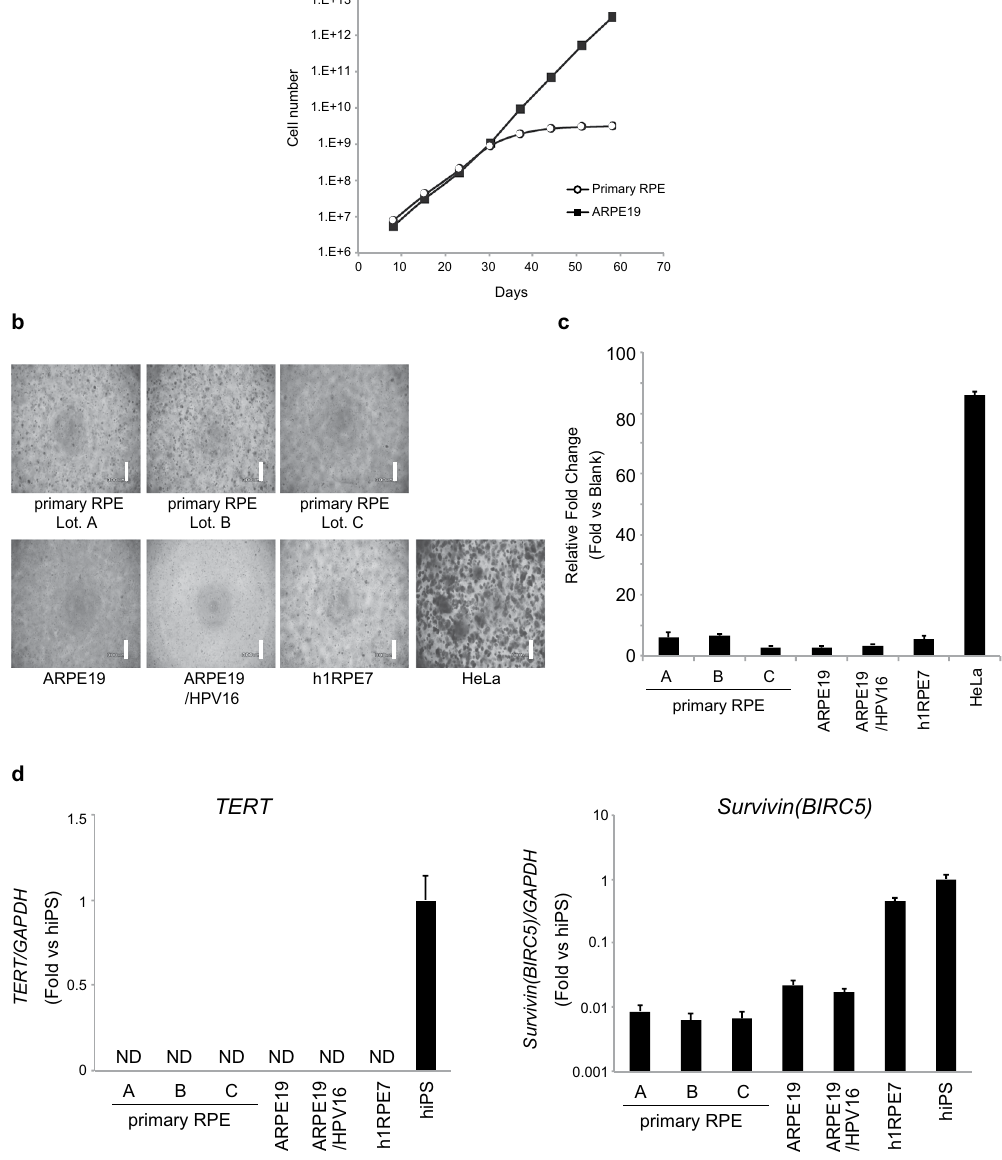
Figure 1. Immortalized RPE cells are undetectable by conventional in vitro assays. ( a ) Cell growth analysis of primary RPE cells and ARPE-19 cells. ( b , c ) A soft agar colony formation assay was carried out to detect immortalized RPE cells. Phase-contrast images of primary RPE cells, immortalized RPE cells, and HeLa cells cultured in soft agar medium for 30 days (b; Scale bars, 300 µ m). Quantification of the cellular DNA is shown in a bar graph. Results were expressed as a relative fold change of the value of blank well. Data are presented as the mean ± standard deviation of three independent experiments (c). (d) The relative mRNA expression of TERT and BIRC5 /Survivin in primary RPE cells, immortalized RPE cells, and hiPSCs was determined by qRT-PCR. Data are presented as the mean ± standard deviation of three independent experiments. N.D.: not